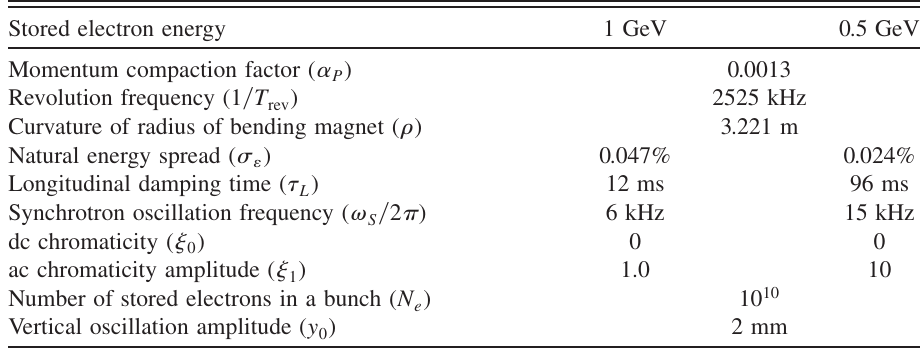
TABLE I. Parameter of NEWSUBARU 12 .